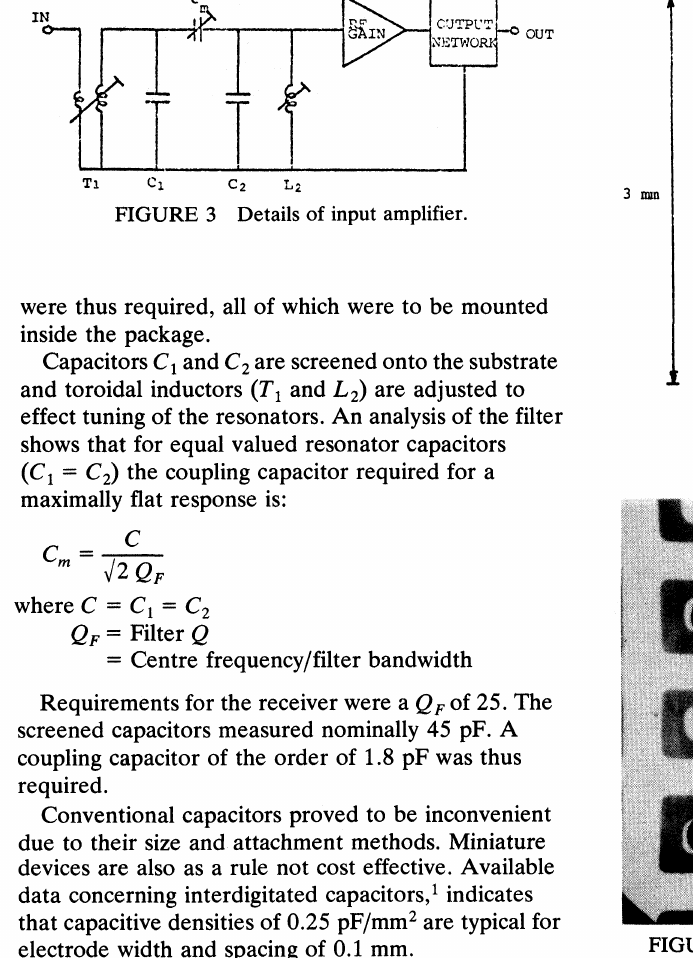
FIGURE 5 Bonding of electrodes on thin film